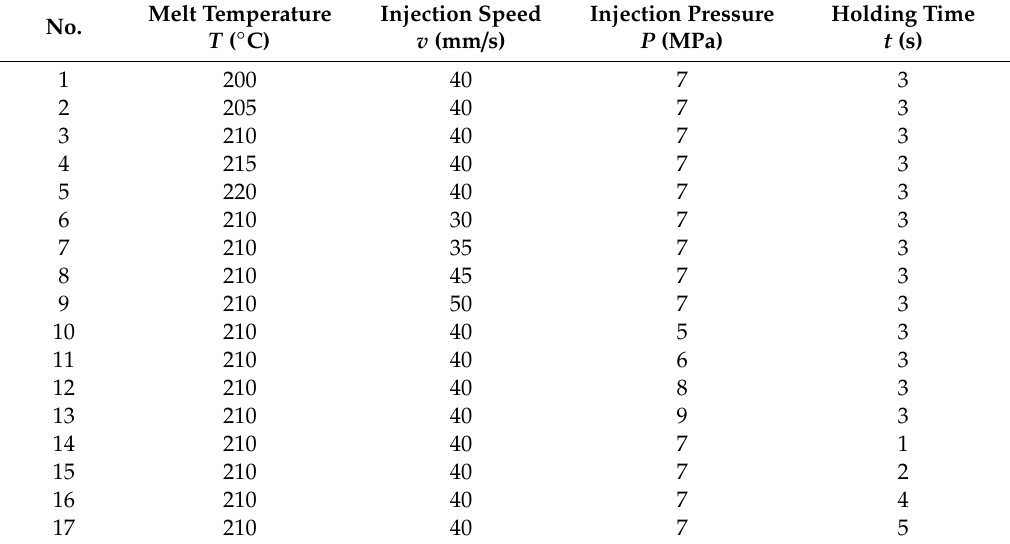
Table 3. Experimental parameter lists of micro injection